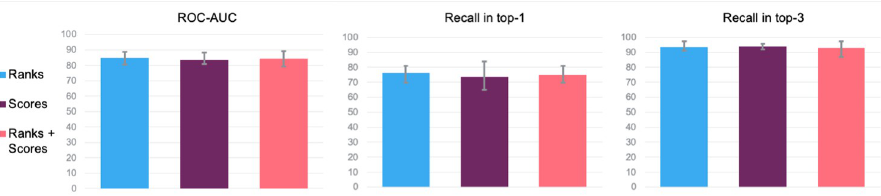
Fig 3. Average performance for different metrics, achieved by the best performing combinations of methods for identifying genes targeted by disease-associated non-coding SNPs. The x-axes list the different methods (represented by different colours), left to right corresponding with the datatype and best combination of methods in Table 4 from top to bottom. The y-axes represent each of the three performance metrics as percentages ranging from 0% to 100%. Error bars indicate the range of the performances of the respective methods across the four reference